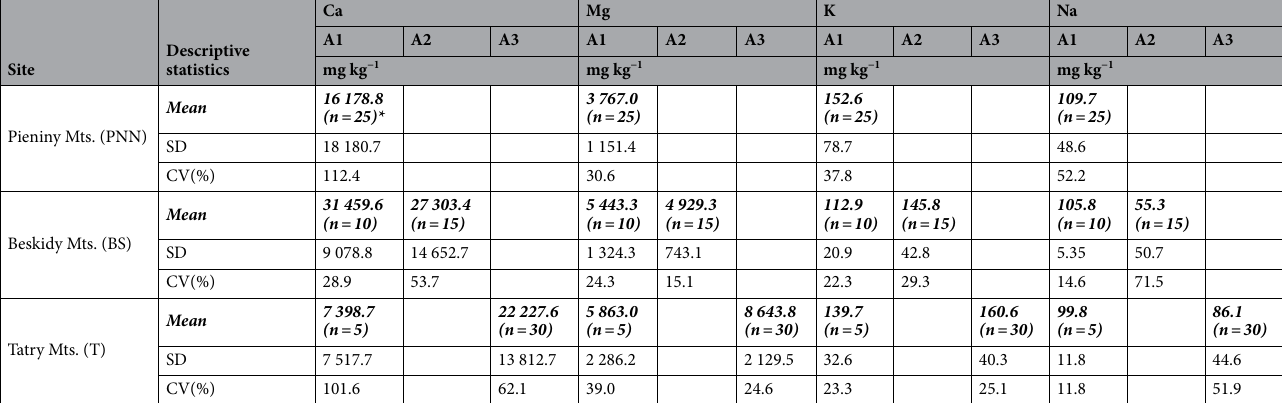
Table 2. Total content of alkaline elements (Ca, Mg, K, Na) in the growth media of A. pinguis cryptic species A genetic lineage A1, A2, A3 at Pieniny, Beskidy and Tatry Mts. *Number of investigated samples.